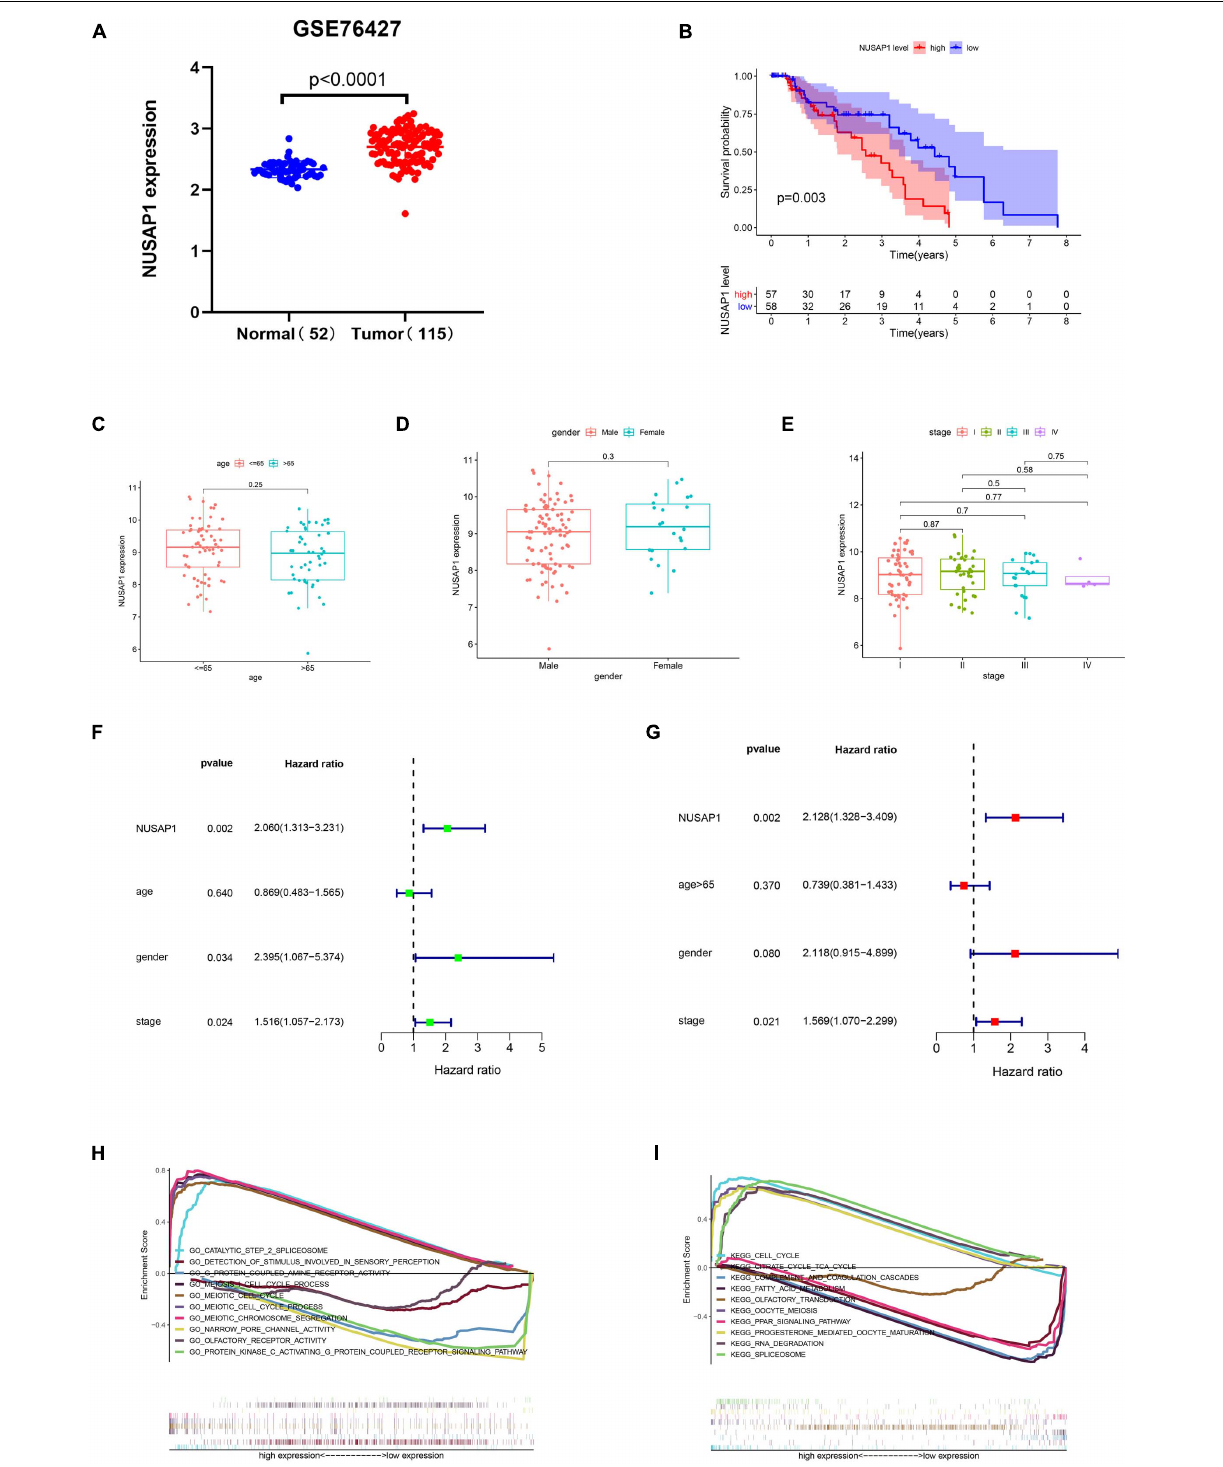
Frontiers in Genetics |